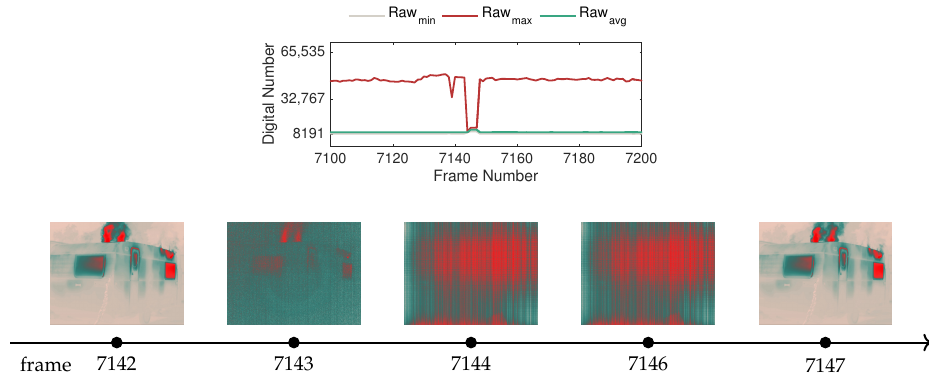
Figure 17. Effect of temperature-dependent non-uniformity correction (NUC), represented by selected samples of the raw data ( top ), along with the respective color-encoded frames ( bottom